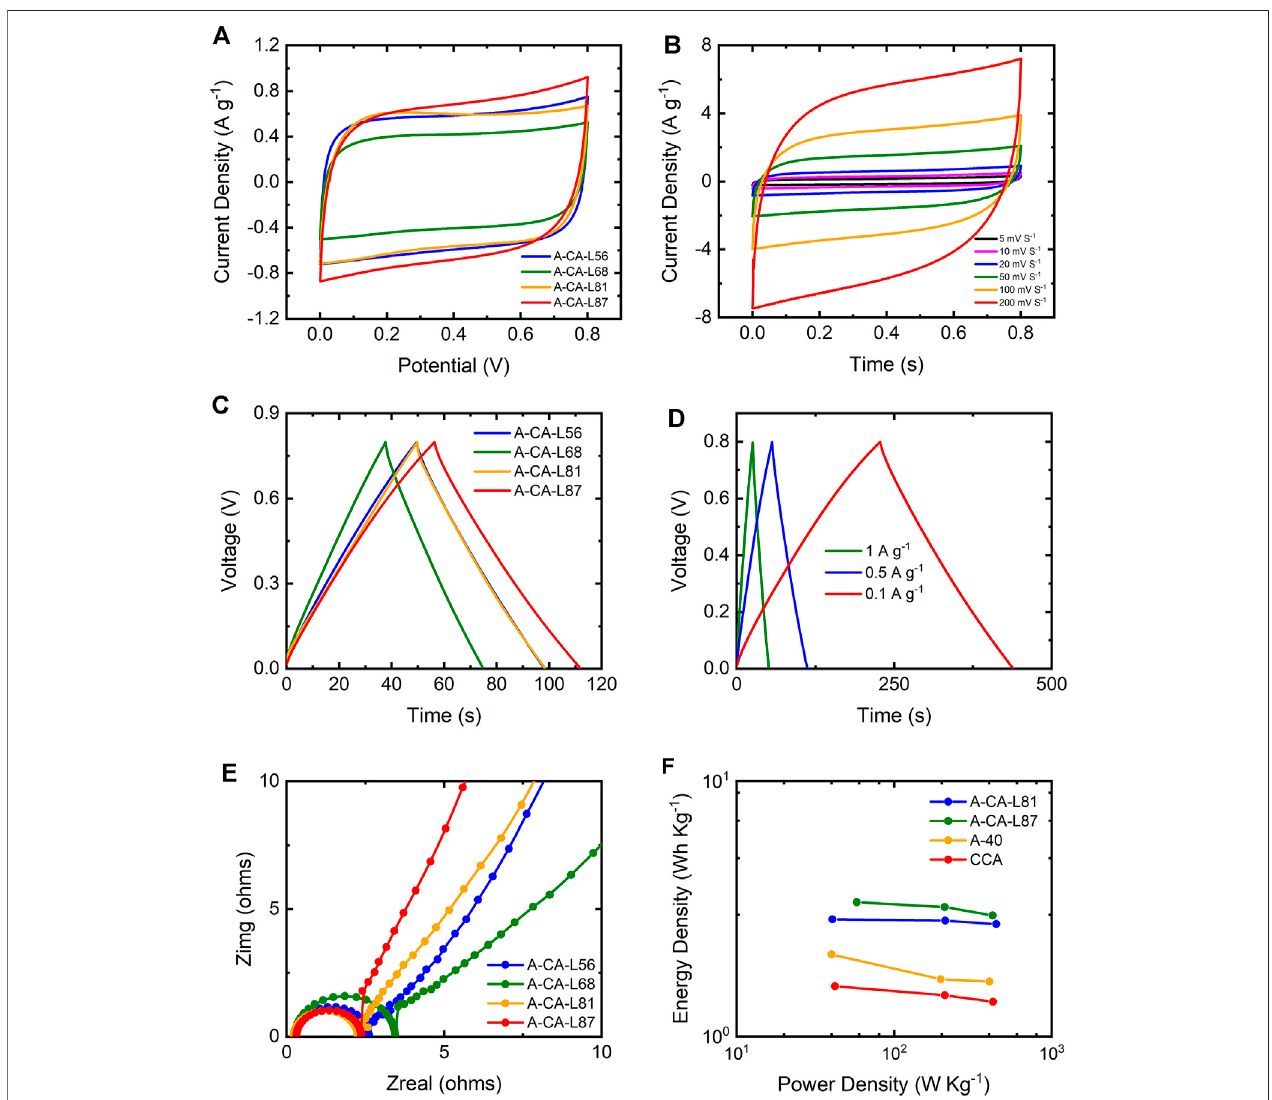
FIGURE 7 | Electrochemical properties of activated lignin carbon aerogels: (A) CV curves of the A-CAs with different lignin contents at the 20 mVs − 1 scan rate and (B) CV curves of A-CA-L87 sample with different scan rates; (C) GCD curves of the A-CA samples at 0.5 Ag − 1 current density and (D) GCD cures of the A-CA-L87 sample at different current densities; (E) Nyquist plots of A-CAs; (F) Ragone plots of A-CA-L87, A-CA-L81 in comparison to a commercial activated carbon (A40) and a RF-based carbon aerogel (CCA).